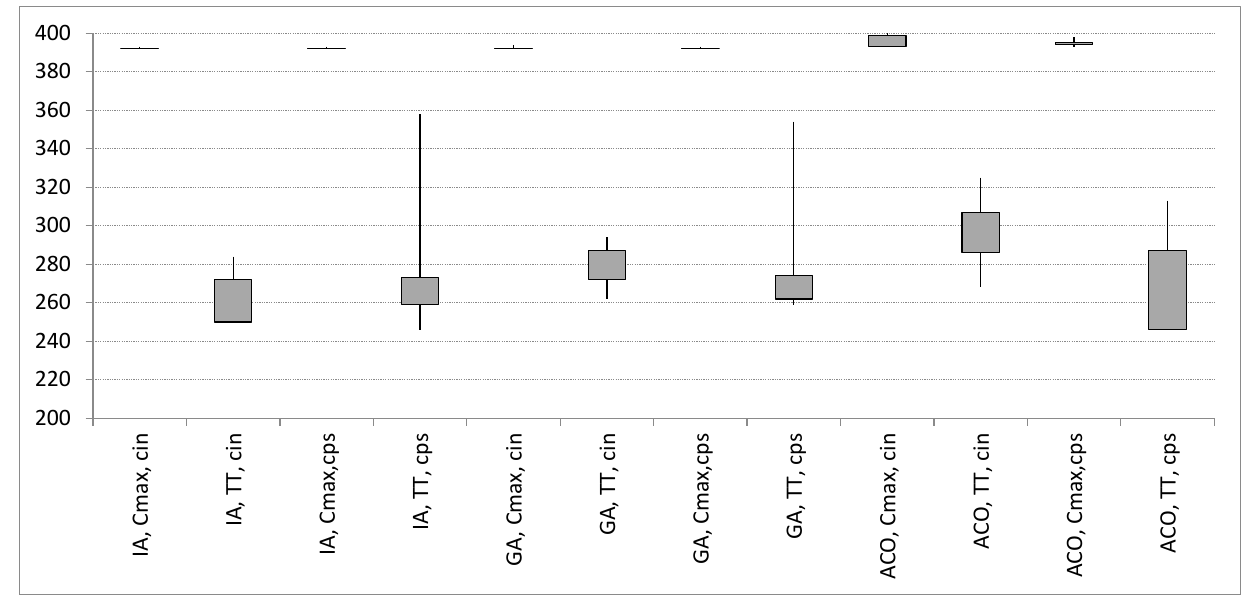
Figure 7. Cmax (Cmax) and TT (TT) obtained by the ACO, GA and IA for changing: number of iterations (cin), size of population (cps).